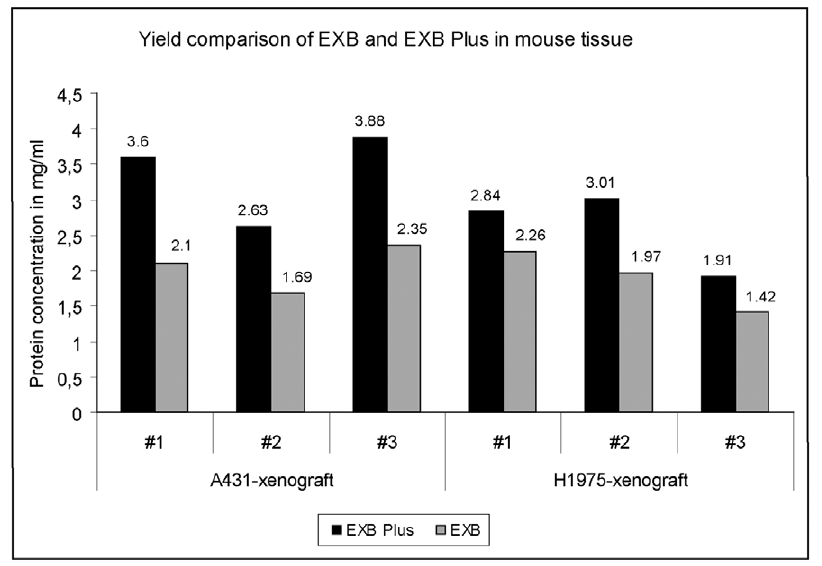
Figure 3. Protein extraction from FFPE samples from two different xenograft mouse models. For both mouse models EXB Plus resulted in higher protein yields compared to EXB. This shows the advantage of EXB Plus independently of the organism.